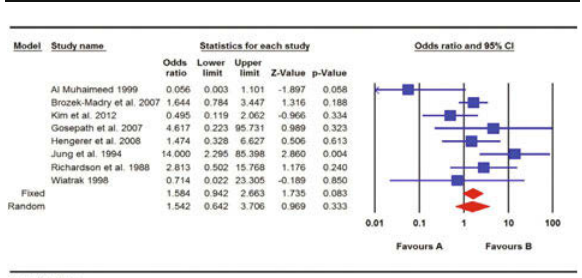
Forest plot for the incidence of restenosis after transnasal or transpalatal repair using the estimated odds ratio (OR) as the